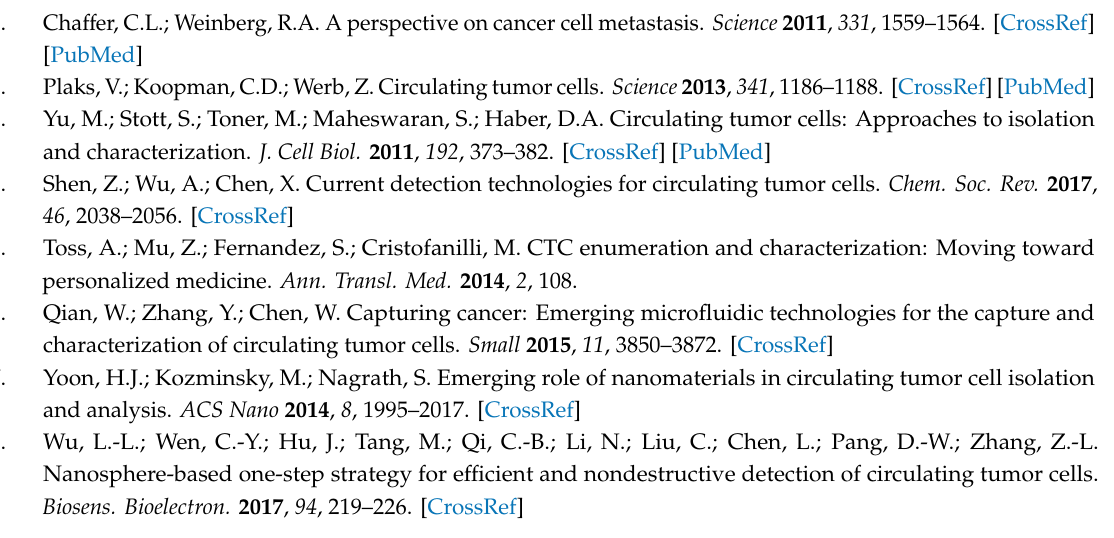
Figure S1: Fluorescence microscope images of the captured MCF7 cells, Figure S2: Raman spectra of the malignant MCF7 cells and non-malignant MCF10A cells on microscope slides, Figure S3: (a,b) Raman spectra of R6G solutions with di ff erent concentrations on the AgNPs-rGO1 SERS substrates; (c) Intensity plot of the 612 cm − 1 as a function of R6G concentration in logarithmic scale. Red line is the linear regression equation, Figure S4: (a,b) Raman spectra of R6G solutions with di ff erent concentrations on the AgNPs-rGO1 SERS substrates; (c) Intensity plot of the 612 cm − 1 as a function of R6G concentration in logarithmic scale. Red line is the linear regression equation, Figure S5: Stability test of the AgNPs-rGO1 SERS substrate. (a) The SERS spectra of 1 µ M R6G solutions during a month; (b–e) The SERS intensity of R6G at the 612 cm − 1 , 773 cm − 1 , 1362 cm − 1 , and 1650 cm − 1 over time, Figure S6: Alexa Fluor 488 dye conjugated antibodies on the substrates. The anti-EpCAM antibodies was functionalized on the substrate through avidin-biotin interaction. The functionalization layer with thickness of ~10 nm involving the uniformly distributed antibodies adhere to the cell surface of 3-D structure resulting in the Raman enhancement of cell components near the substrates, Figure S7: Alexa Fluor 488 dye conjugated antibodies on the substrates. The anti-EpCAM antibodies was functionalized on the substrate through avidin-biotin interaction. The functionalization layer with thickness of ~10 nm involving the uniformly distributed antibodies adhere to the cell surface of 3-D structure resulting in the Raman enhancement of cell components near the substrates, Figure S8: (a) Contact angle of the AgNWs film and the AgNWs-GO1 film. Inset photographs are water droplets on the films; (b) Sti ff ness of the AgNWs film and the AgNWs-GO1 film. The films was tested in indent depth of 100 nm, Figure S9: (a) Contact angle of the AgNWs film and the AgNWs-GO1 film. Inset photographs are water droplets on the films; (b) Sti ff ness of the AgNWs film and the AgNWs-GO1 film. The films was tested in indent depth of 100 nm, Table S1: Assignment of Raman bands of the MCF7 and MCF10A cells, Table S2: Molecular assignment of Raman bands of the MCF7 and MCF10A